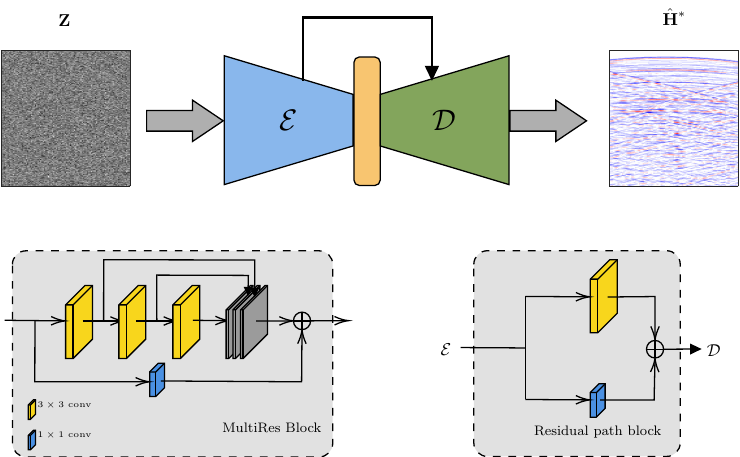
Figure 2. The overall block scheme of the Unet-like structure of the network, along with the block diagrams of MultiRes and Residual path